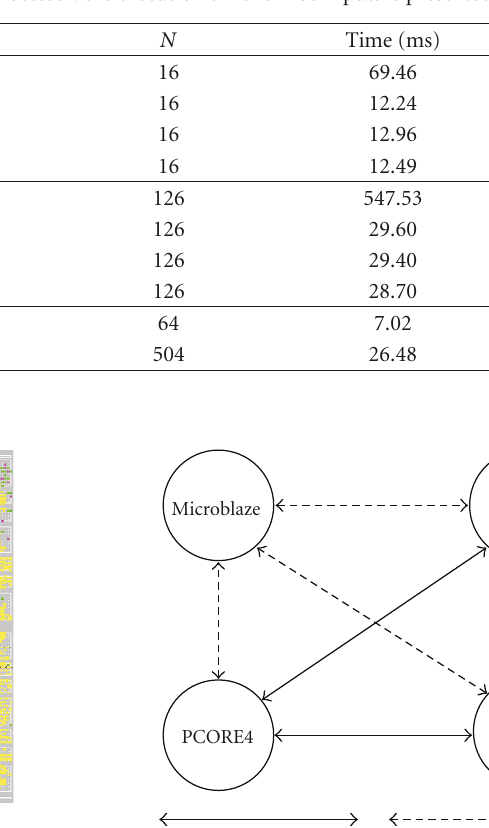
Figure 6: The RLS lattice coprocessor integration to Microblaze processor via FSL. Table 3: Performance of the RLS lattice coprocessor: the execution time for 180 inputs is presented.